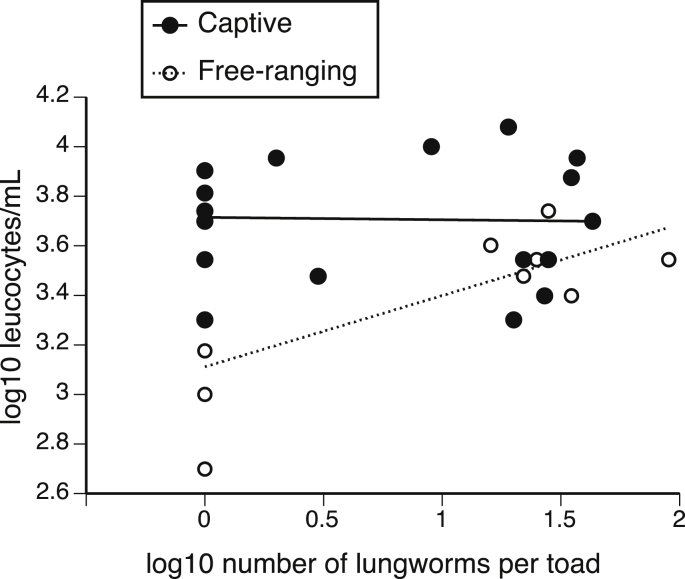
The effects of lungworm (Rhabdias pseudosphaerocephala) abundance on leukocyte concentrations in cane toads. Captive toads (n = 19) exhibited high leukocyte concentrations that were independent of the level of Rhabdias infection. In contrast, leukocyte concentrations in free-ranging toads (n = 11) increased with Rhabdias infection level.